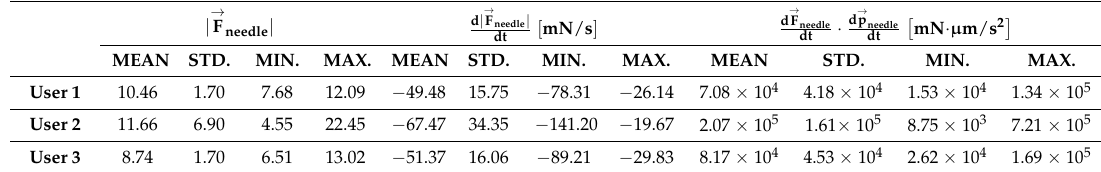
Table 3. Force characteristics associated with the instant of puncture for three different users (n = 24 trials/user).